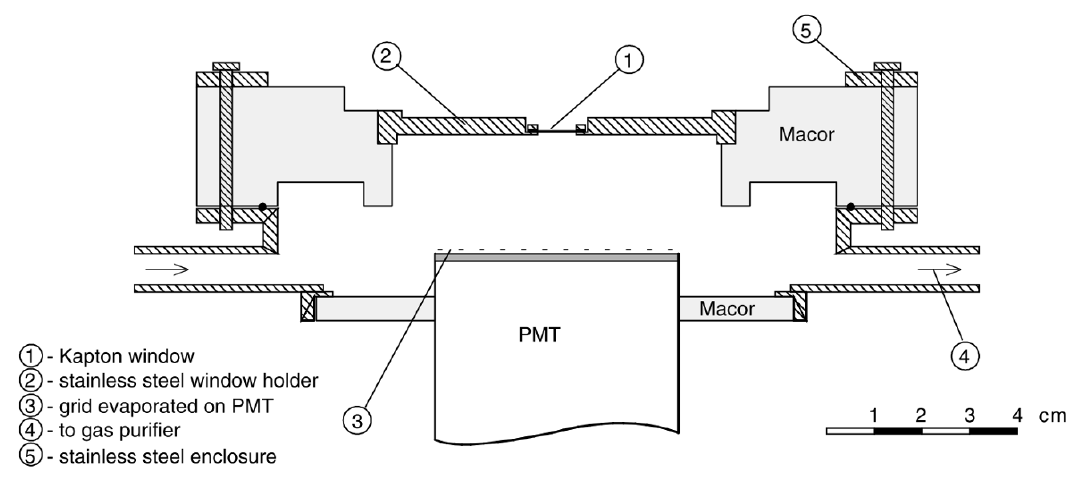
Figure 1 . Scheme of the driftless GPSC used in this work [30]. A PMT is used as VUV photosensor and the gas is continuously puri(cid:12)ed through SAES St707